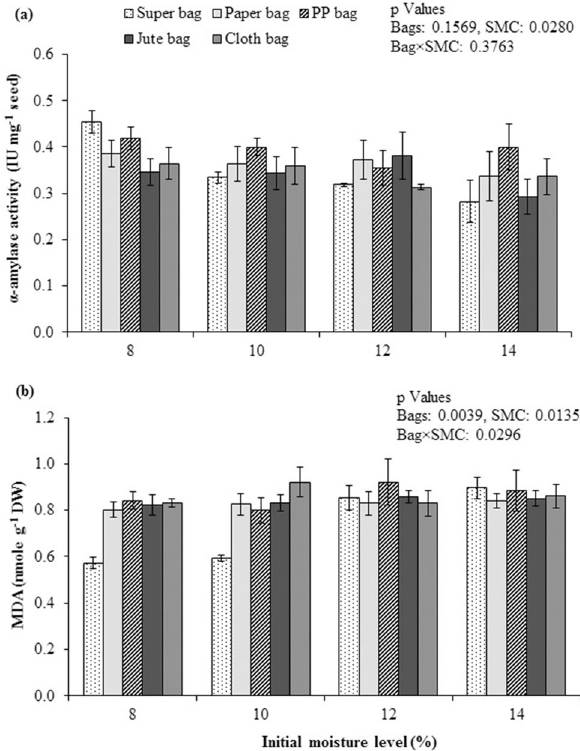
Figure 5. α-amylase activity ( a ) and malondialdehyde (MDA) contents ( b ) of quinoa seed stored at various seed moisture levels in different packaging